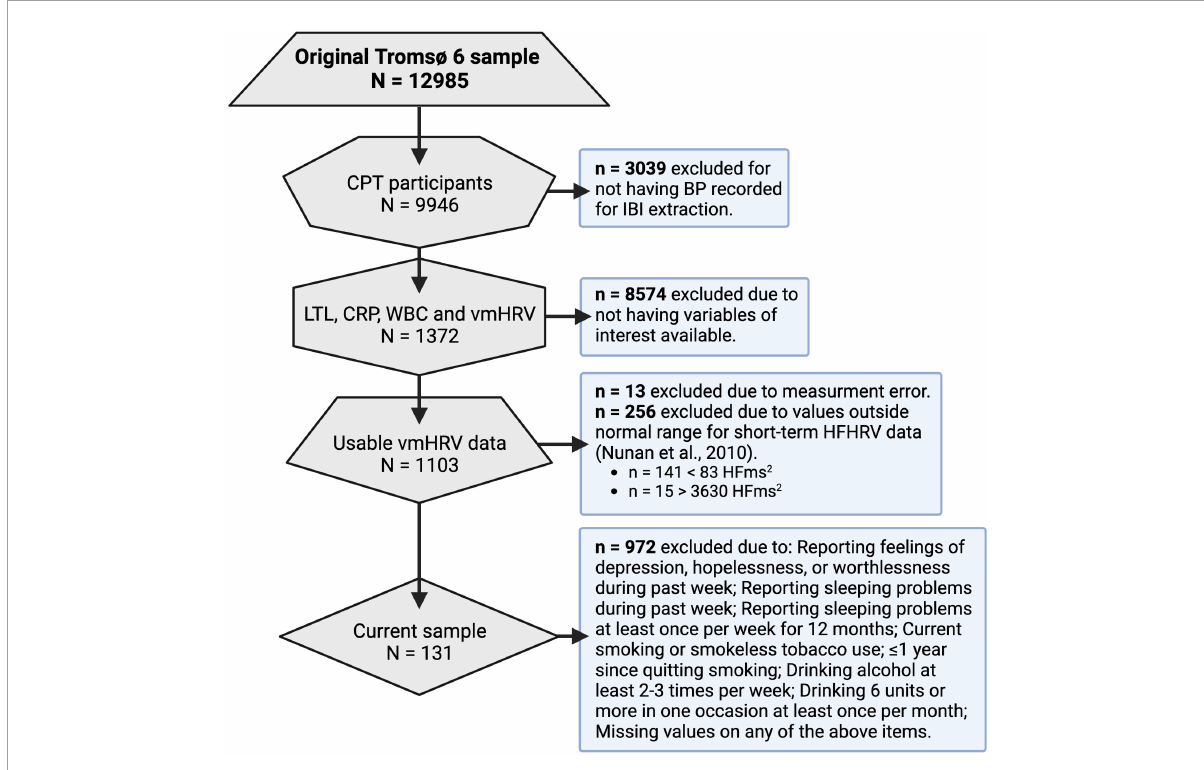
FIGURE2 Data reduction process. CPT, cold-pressor test; BP, blood pressure; IBI, inter-beat interval; LTL, leukocyte telomere length; CRP, c reactive protein; WBC, white blood cell count; vmHRV, vagally mediated heart rate variability; HFms 2 , high frequency component